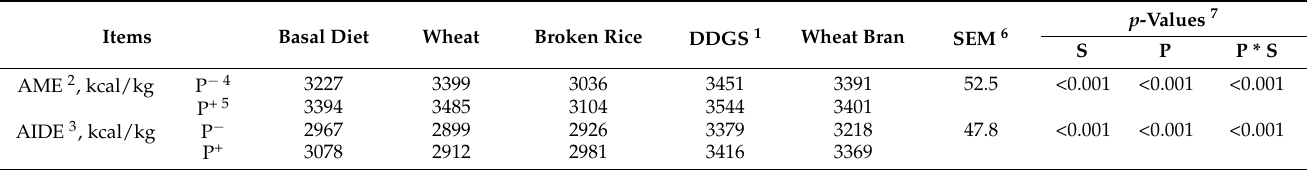
Table 4. AME and IDE in different broiler diets with or without added phytase.